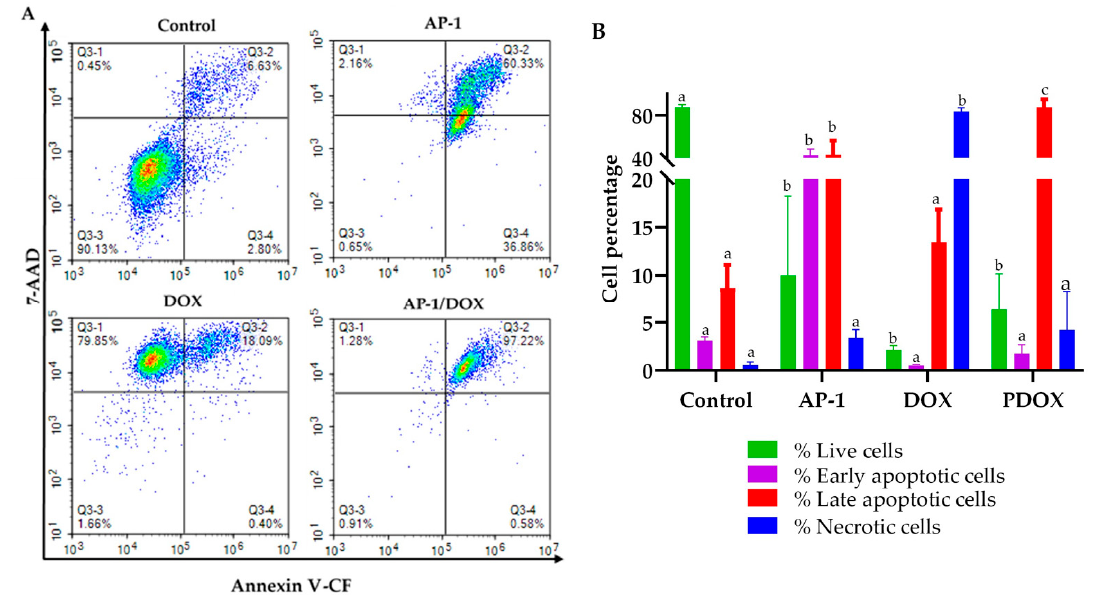
Figure 6. ( A ) Flow cytometric assessment of apoptotic profiles of the MCF7 breast cancer cell line and the images are representative of three separate experiments, ( B ) Cell percentage analysis in different treatment groups in quadruplicates. The AP-1 (100 µ g mL − 1 ), DOX (0.29 µ g mL − 1 ) and their most synergistic combination (at half-dose; 50 µ g mL − 1 AP-1 + 0.15 µ g mL − 1 DOX) with the vehicle control were implemented using antibodies against Annexin-V CF-Blue and the reporter 7AAD after 24 h of treatment. Superscript letters indicate statistical significance derived from two-way ANOVA and Tukey’s multiple comparisons within the same cell group (bar colour) where different letters are statistically significant with p < 0.0001 ( n = 4). Raw data are available in Supplementary Table